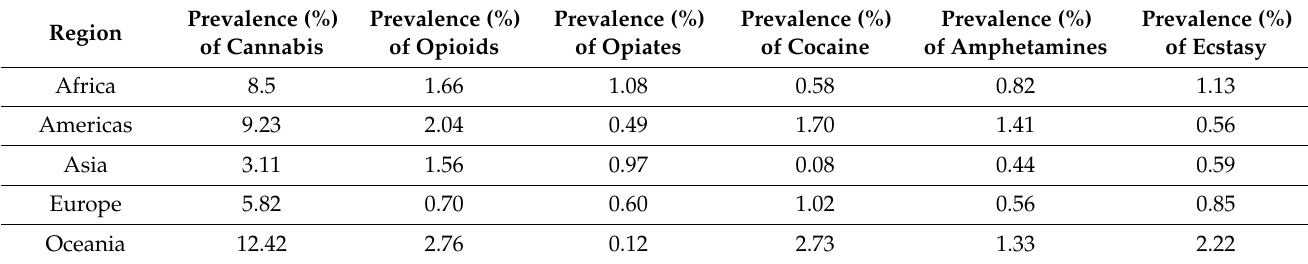
Table 3. Prevalence of various substances by region in the year